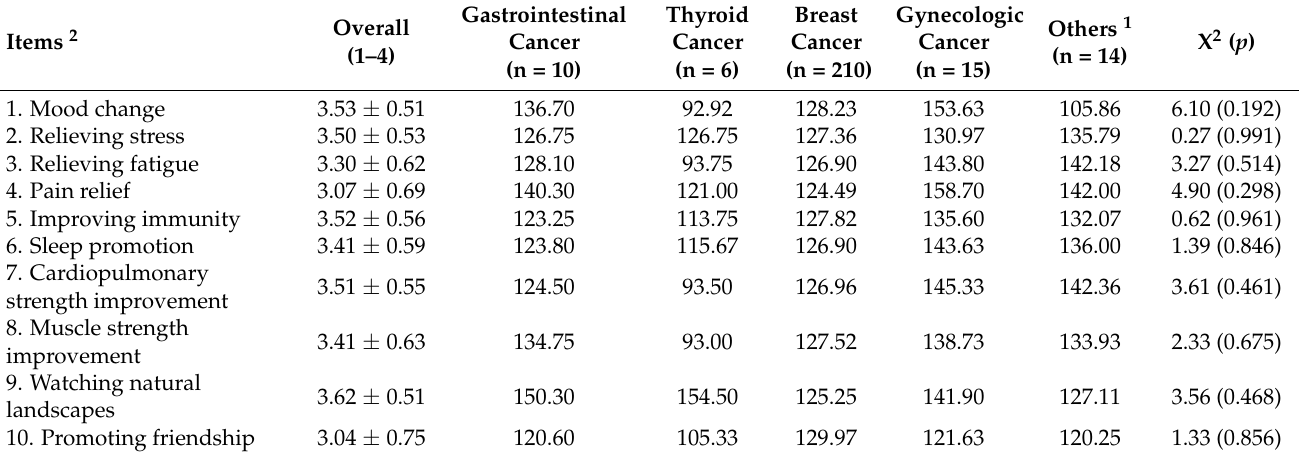
Table 6. Purpose of urban forest healing program (N =